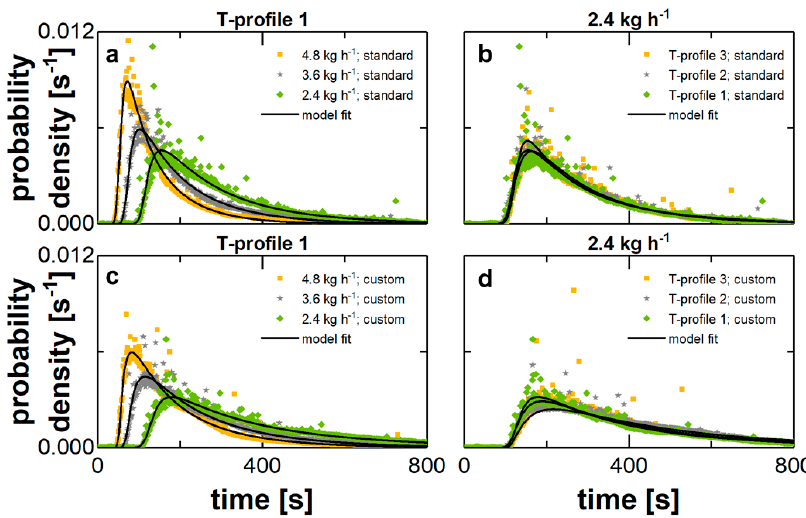
Figure 2. Effect of investigated parameters on the RTD. Determined residence time density functions for each parameter set are represented by the run, which symbolizes the average of the three repetitions: ( a ) variation of mass flow for standard elements; ( b ) variation of temperature profile for standard elements; ( c ) variation of mass flow for customized elements; ( d ) variation of temperature profile for customized elements.